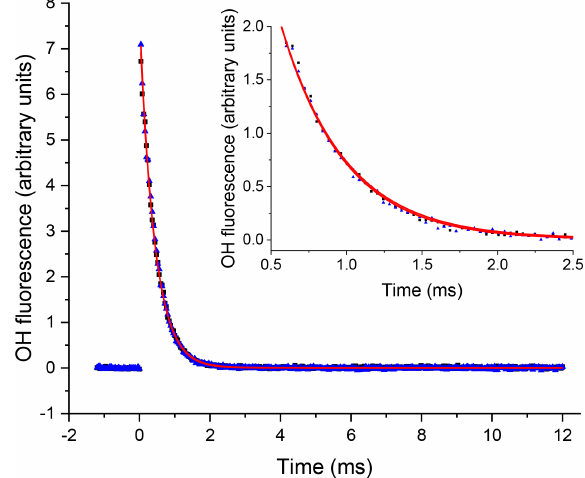
Figure 3. An example of the OH signal (solid blue triangles) col- lected at the first detection axis for the reaction of OH with H 2 O 2 ([H 2 O 2 ] ≈ 1 . 4 × 10 15 molec.cm − 3 , with a flow of N 2 into the low- pressure cell, with open black squares representing the subsequent trace taken with a flow of NO. The red lines represent the non- linear least-squares fits to an exponential decay ( k OH , 1st = ( 2351 ± 22 ) s − 1 and k OH , 1st = ( 2389 ± 18 ) s − 1 ), 2 σ errors.